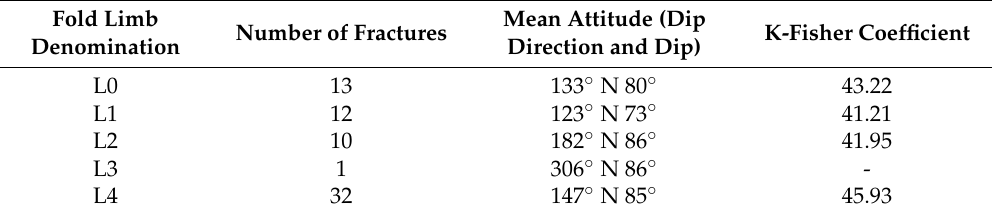
Table 9. Features of fracture set K2 determined in the different fold limbs.